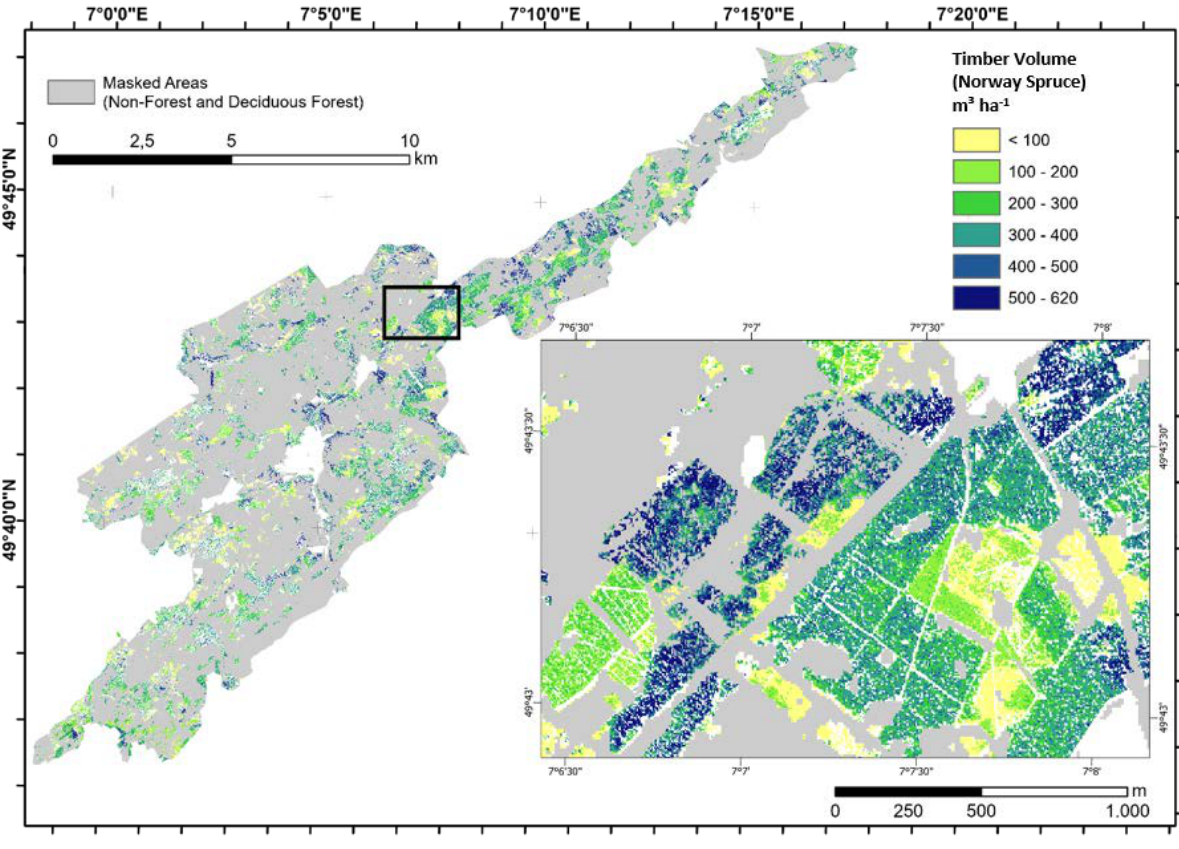
Figure 6. Distribution of k-NN derived Norway spruce volume in the National Park Hunsrück-Hochwald. The inlay shows the now deforested area near Thranenweier (49° 72’ N, 7° 11’ E).